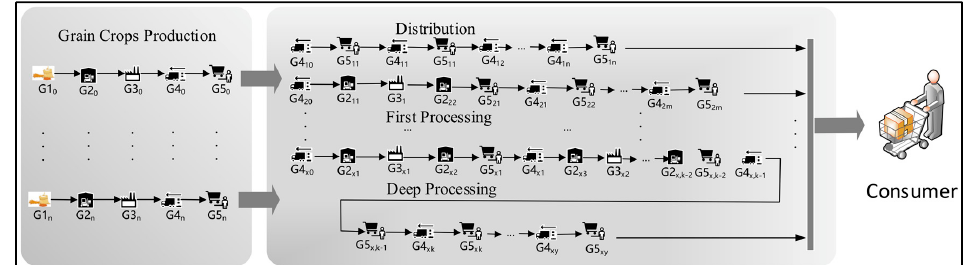
Figure 4. Structure of the Grain Supply Chain [38] (p.